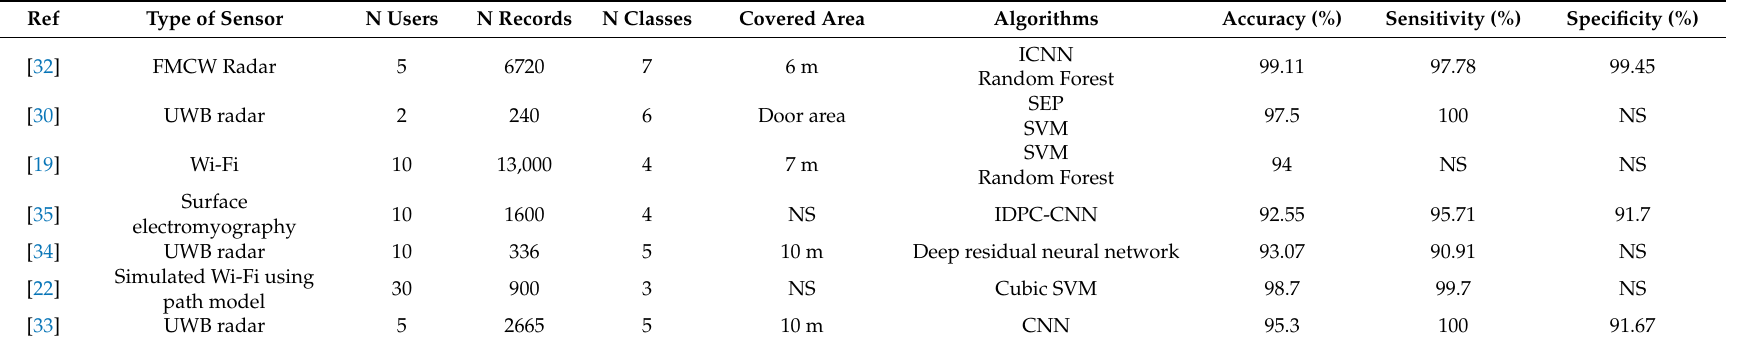
Table 1. Summary of recent studies about fall detection systems based on machine learning